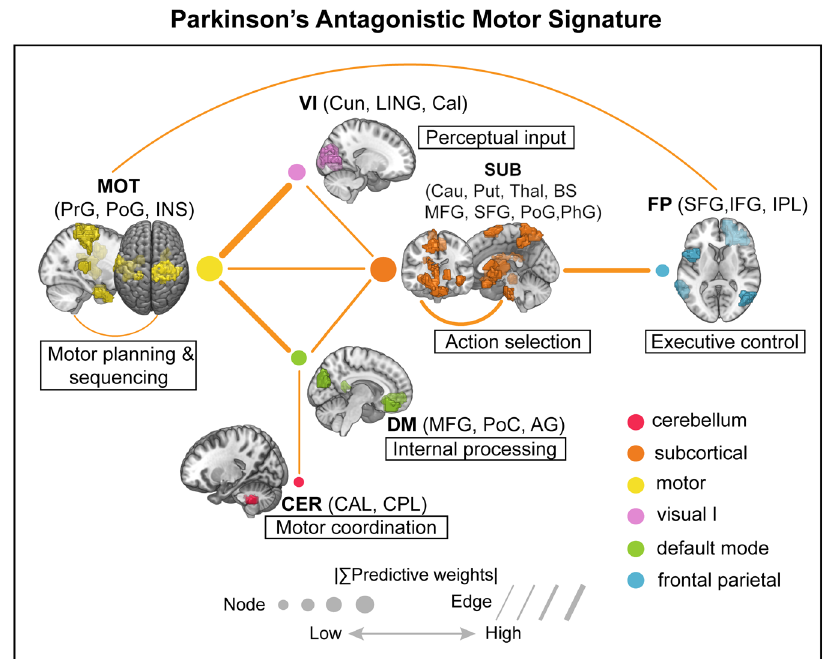
Fig. 6 Parkinson ’ s antagonistic motor signature (PAMS): a functional connectivity biomarker of motor dysfunction in PD. We sketched the top ten predictive network pairs in the fi nal model. The widths of dots and lines are proportional to the predictive weights. We also showed the function of each network according to previous literature and the corresponding anatomical regions. PrG precentral gyrus, PoG postcentral gyrus, INS insula gyrus, Cun cuneus, LING lingual gyrus, Cal calcarine, Cau caudate; Put putamen, Thal thalamus; BS brainstem, MFG medial frontal gyrus, SFG superior frontal gyrus, PhG parahippocampa gyrus; IFG inferior frontal gyrus, IPL inferior parietal lobe, PoC posterior cingulate, AG angular gyrus, CAL cerebellum anterior lobe, CPL cerebellum posterior